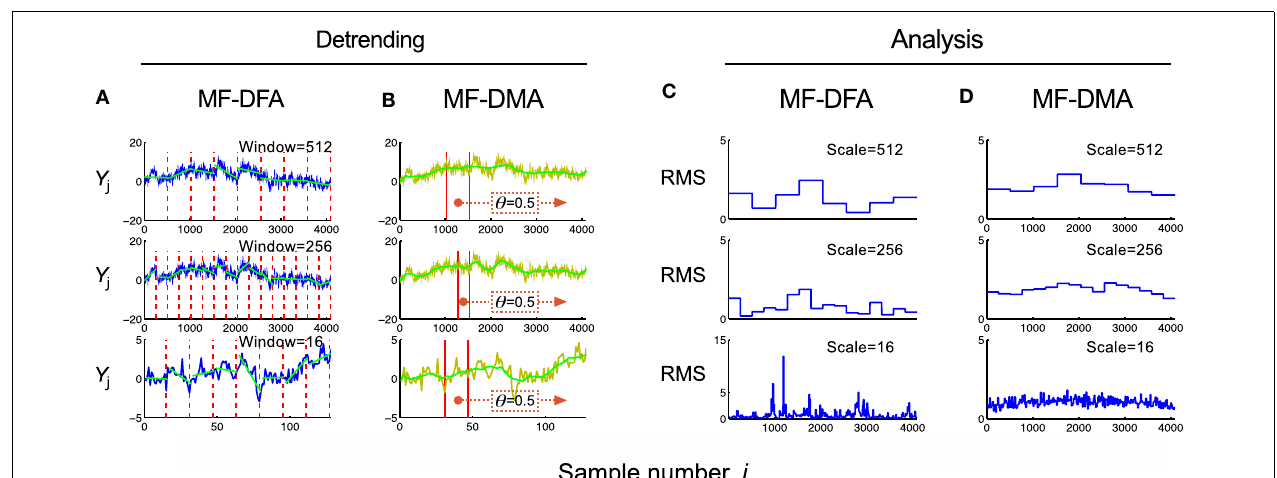
interval, 0 meaning only from signal values on the left (“ backward ,” past), in contrast with 1 meaning that only signal values to the right (“ forward ,” future) are used for calculating ˜ Y j .The centrally positioned sliding window corresponds to the case of θ = 0.5 balancing contributions from the past and the future to the reference point.The approaches of MF-DFA and MF-DMA thus ought to yield different detrended signals, whose calculated moments (C,D) and Eqs 33 and 34 obtained by the analysis should also be somewhat